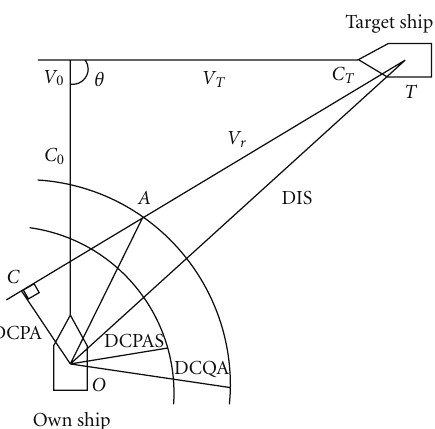
Figure 4: Relative motion diagram of own ship and target